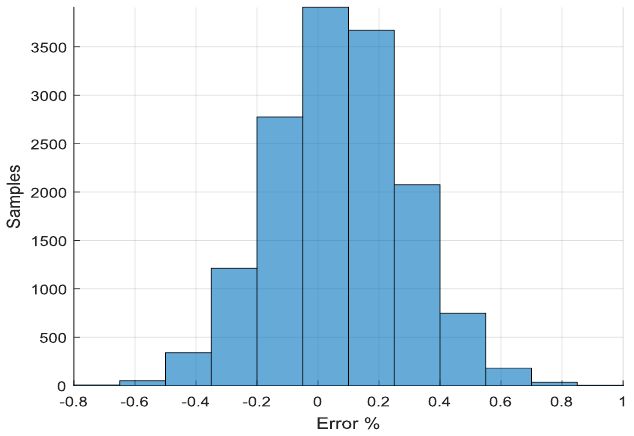
Figure 12. Signal precision for 60 sec recording (F s = 250 Hz, PGA = 6).